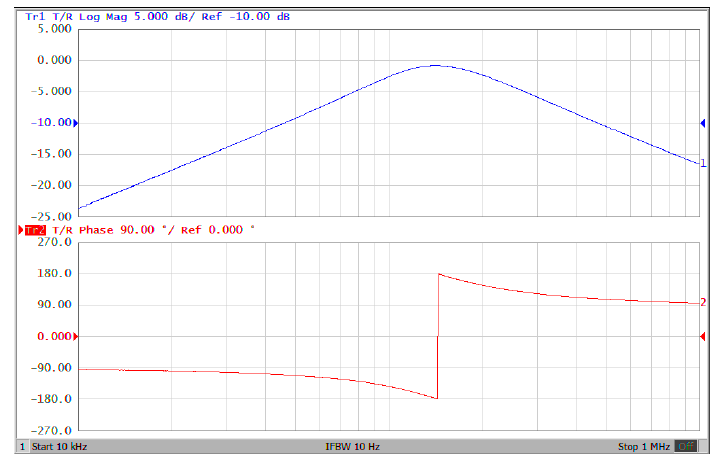
Figure 36. Experimentally observed gain and phase responses of the IBP filter realized in case II.